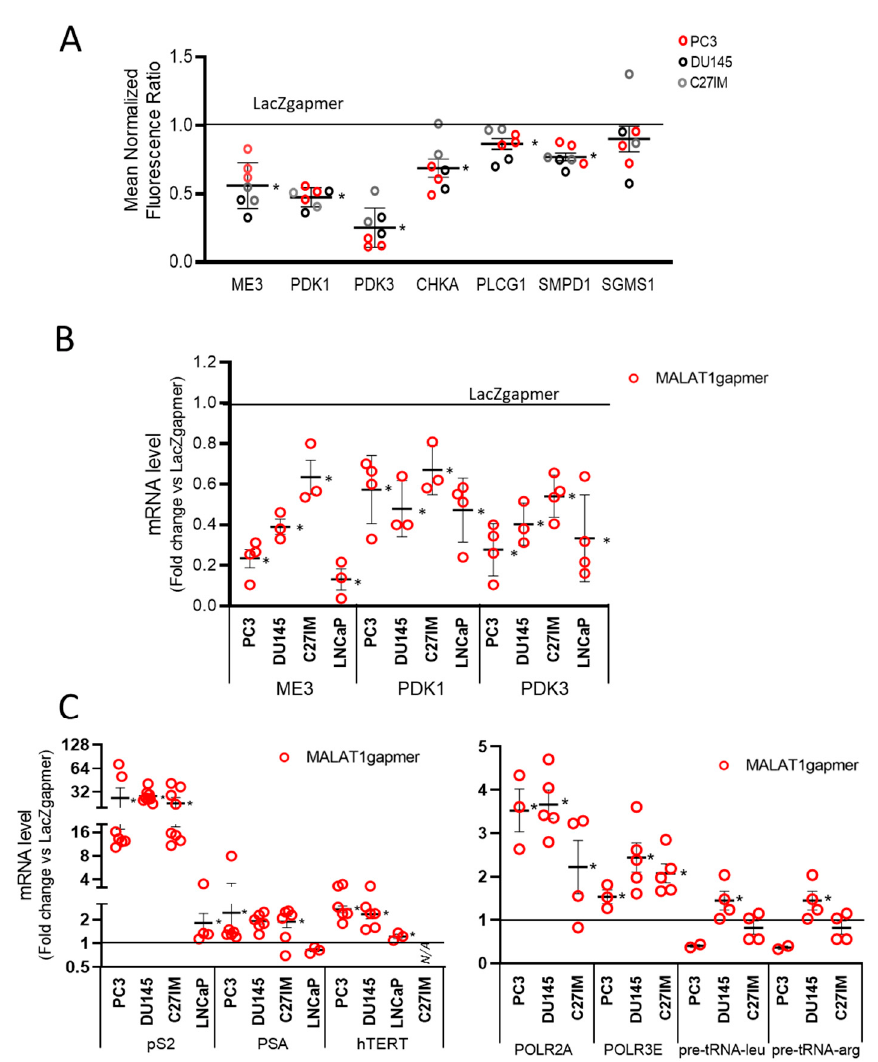
Figure 3. Validation of array data in PCa cells by qRT-PCR. ( A ) Differential expression of genes as emerging from transcriptomic analysis before/after MALAT1 depletion in C27IM, DU145, and PC3 cells. Transcript levels of ME3, PDK3, PDK1, and PCho-related genes (choline kinase A (CHKA), Phospholipase C Gamma 1 (PLGC1), sphingomyelin phosphodiesterase 1 (SMPD1), and sphingomyelin synthase 1 (SGMS1)) are expressed as fold change vs. LacZgapmer (mean ± SEM are showed). ( B , C ) mRNA expression level of those genes emerging as differentially modulated were validated in different PCa cells (PC3, DU145, C27IM, and LNCaP) transfected with specific gapmer for MALAT1 or LacZ. Results are plotted as fold induction vs. LacZgapmer (placed to 1 and depicted as a black line). Individual values ( n = 3–8) with mean ± SEM are showed. Non-parametric paired two-tailed Student’s t -test determined statistical significance. * p ≤ 0.05 MALAT1gapmer vs. LacZgapmer. * p < 0.05 vs. gapmerLacZ.